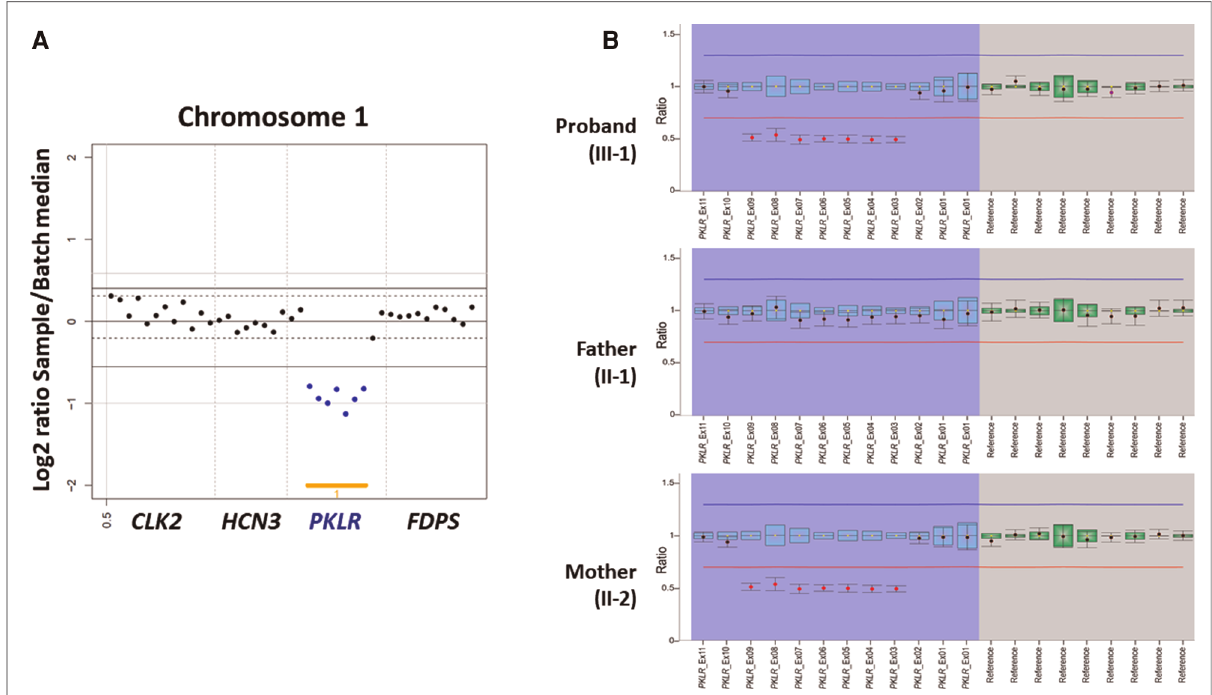
FIGURE 2 Heterozygous PKLR deletion identi fi ed by copy number variation (CNV) analysis using next-generation sequencing and multiplex ligation-dependent probe ampli fi cation (MLPA) in a proband with pyruvate kinase de fi ciency. ( A ) VisCap, a copy number detection and visualization tool, illustrated a heterozygous 2.6 Kb deletion of chromosome 1q22 (chr1:155,262,957-155,265,561), including a region between exon 3 and exon 9 of the PKLR with a Z ratio of − 0.5 to − 1 in the proband (indicated by solid blue dots under than lower normal limit of − 0.5). ( B ) MLPA demonstrating the same heterozygous deletion identi fi ed previously by CNV analysis with NGS data in the proband and her mother (indicated by solid red dots under than lower normal limit of